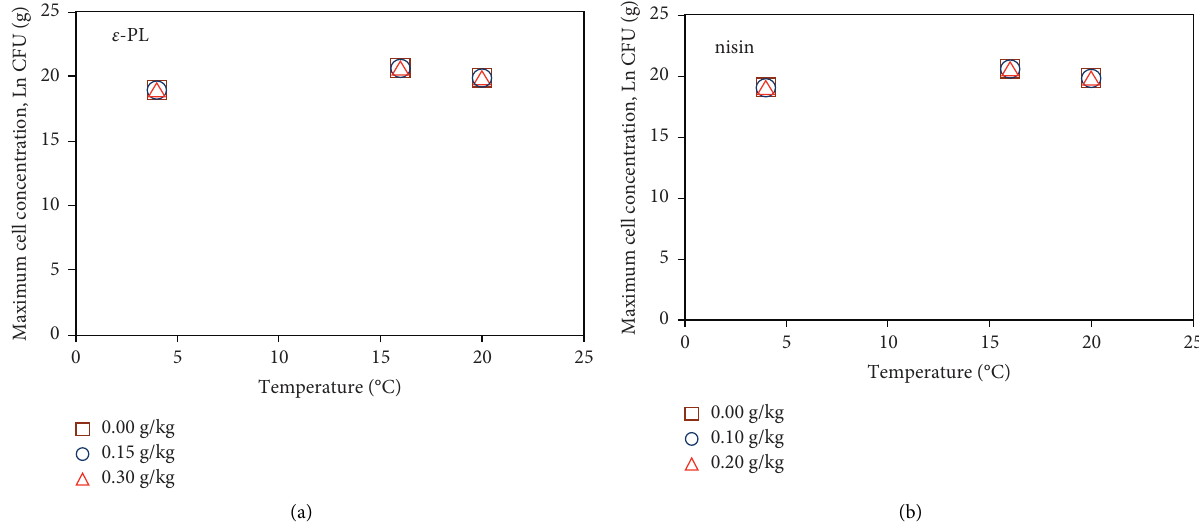
Figure 4: The maximum population of BK microorganisms in FVFB: (a) ε -PL treated and (b) nisin treated.